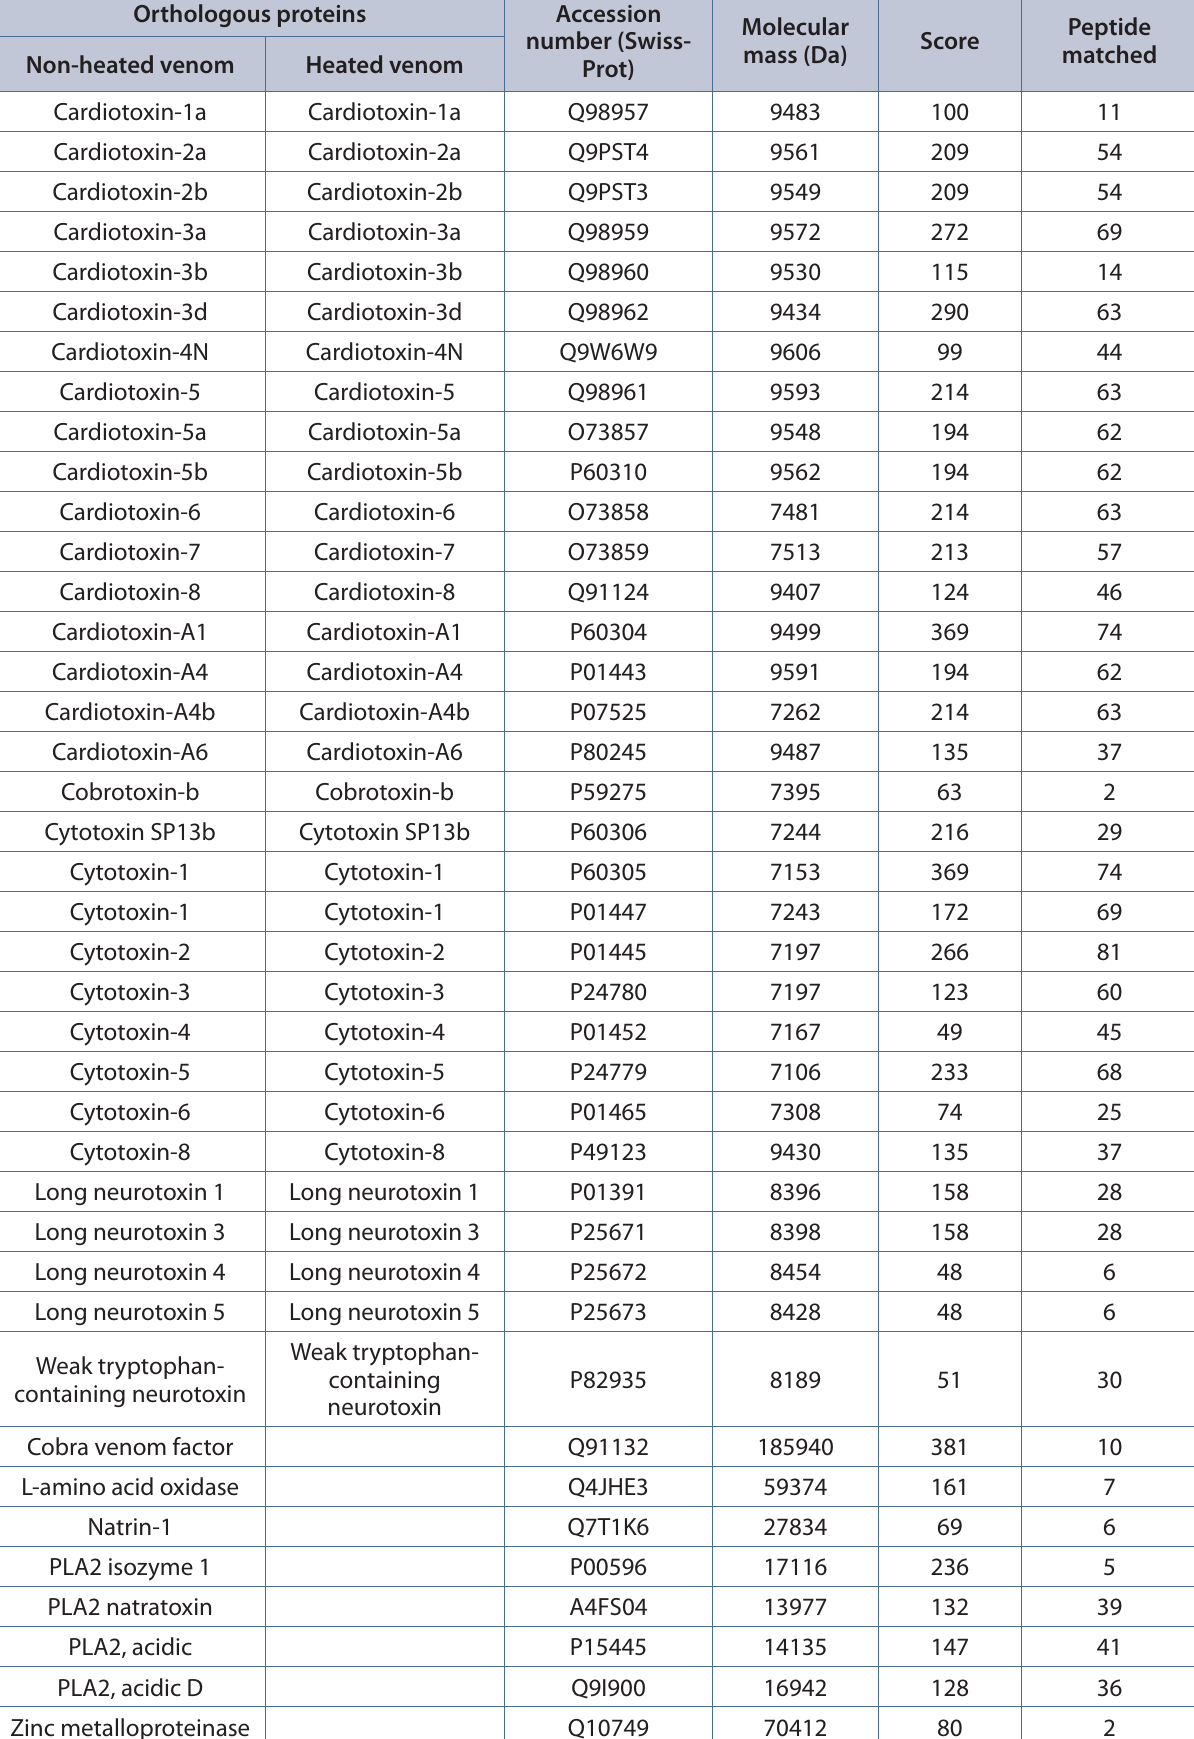
Table 1. Proteins and peptides from non-heated and heated cobra venom identified by LC MS/MS Orthologous proteins Accession Molecular Prot)